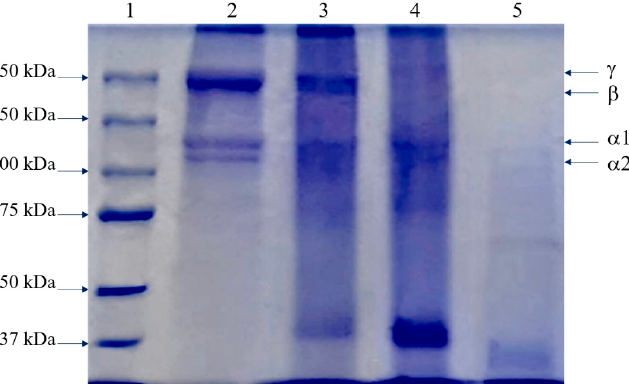
Figure 6. SDS–PAGE pattern of collagen from the tuna-tail tendon, Marker (1), Calf skin (2), VTC: acid-solubilized collagen using vinegar extraction (3), ATC: acid-solubilized collagen using acetic- acid extraction (4), APTC: pepsin-solubilized collagen (5). extraction (4), APTC: pepsin-solubilized collagen